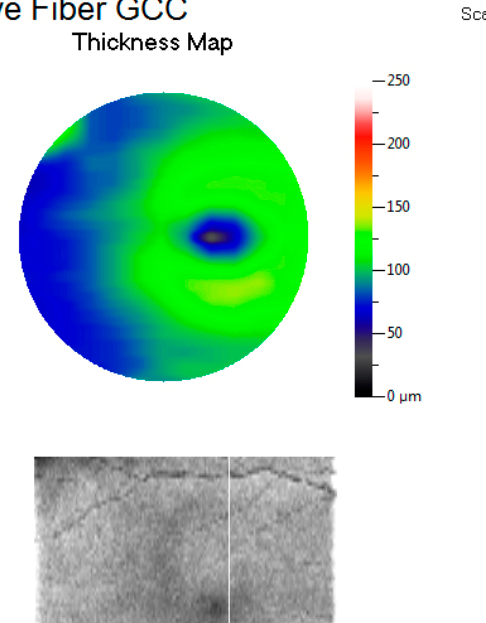
ments were further recorded into a quadrantic map for the superior, inferior, nasal, and temporal subfields. The average measurements for the average ONH-RNFL, the inferior hemisphere ONH-RNFL, the superior hemisphere ONH-RNFL, the superior quadrant ONH-RNFL, the inferior quadrant ONH-RNFL, the nasal quadrant ONH-RNFL, and the temporal quadrant ONH-RNFL thicknesses were captured for each eye and compared to the control